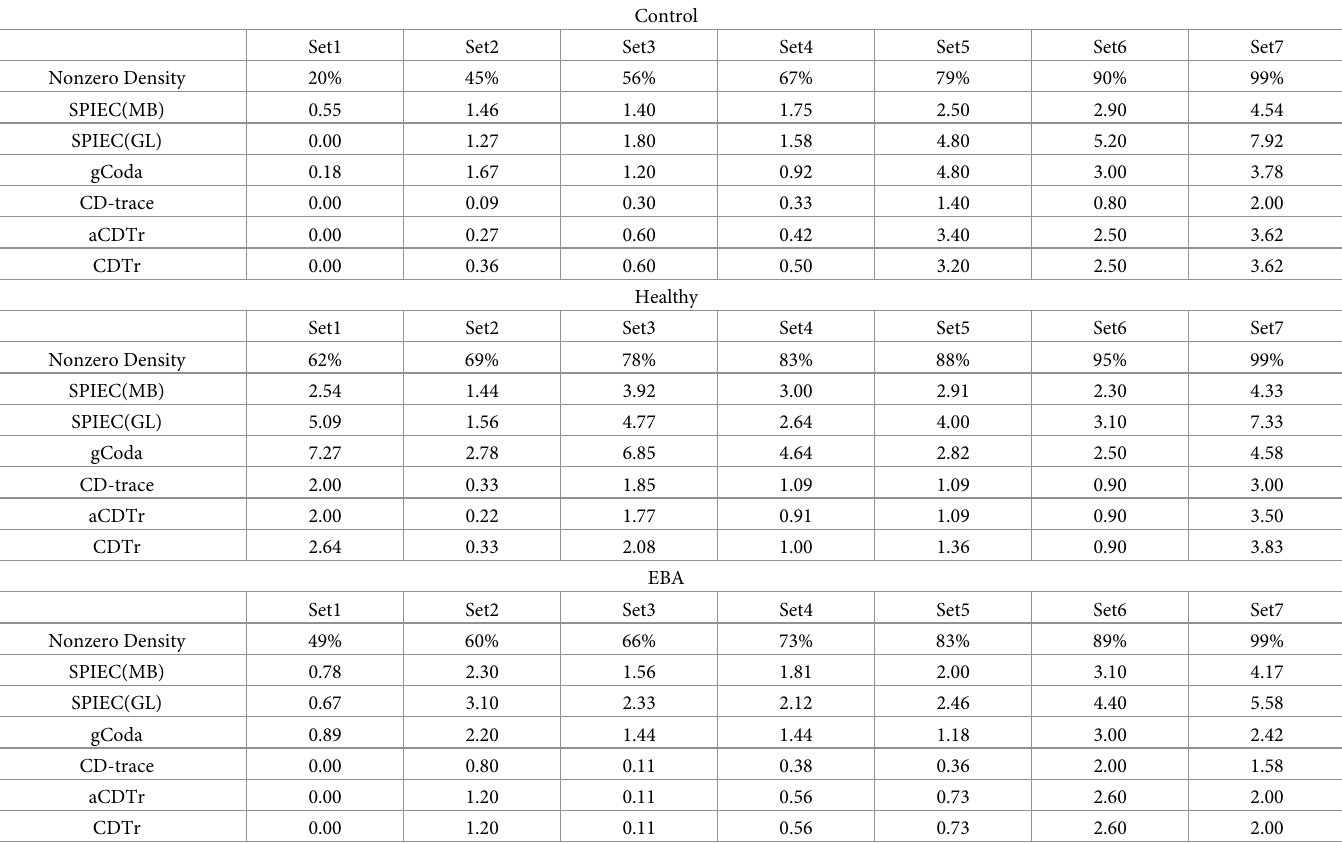
Table 9. The nonzero density and average degree for each set and networks constructed by various methods in control, healthy and EBA